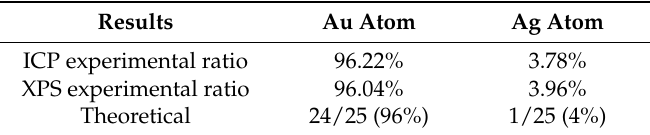
(XPS) measurements.